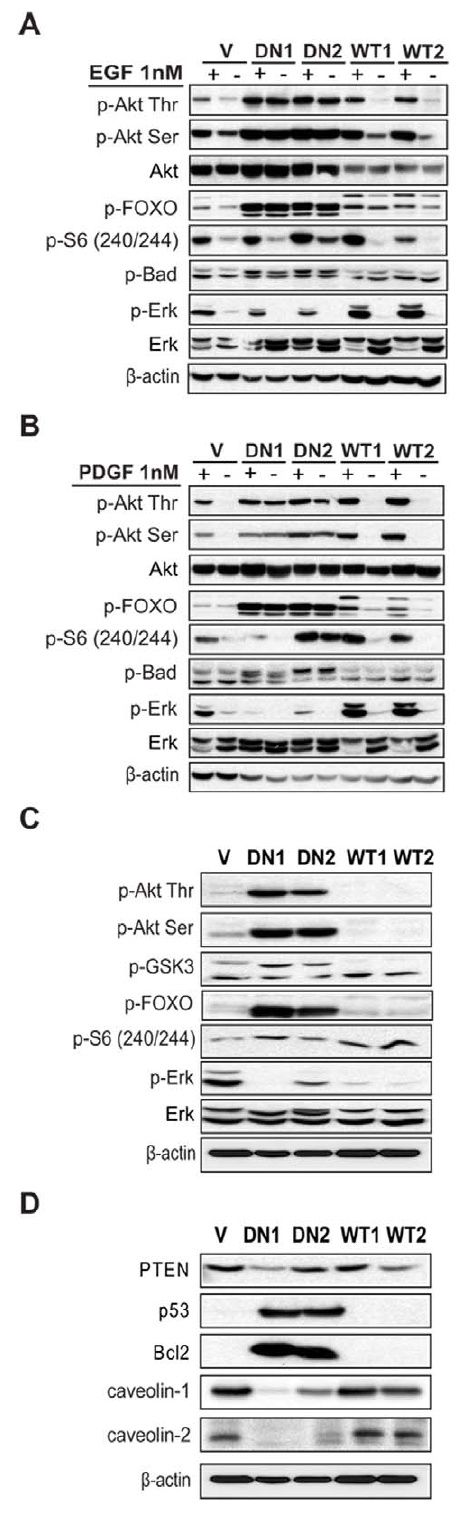
Figure 6. PI3KC2 b protects NIH3T3 cells against anoikis. (A) NIH3T3-V, -C2 b -DN and -C2 b -WT cells were plated in presence of serum on ultra-low attachment matrix. After 16 h Caspase 3/7 activity was measured as readout for detachment-induced apoptosis (anoikis). Data are mean 6 SD of two independent experiments. WT1, 2 2 and DN1, 2 2 indicate individual clones. (B) NIH3T3 cells transiently